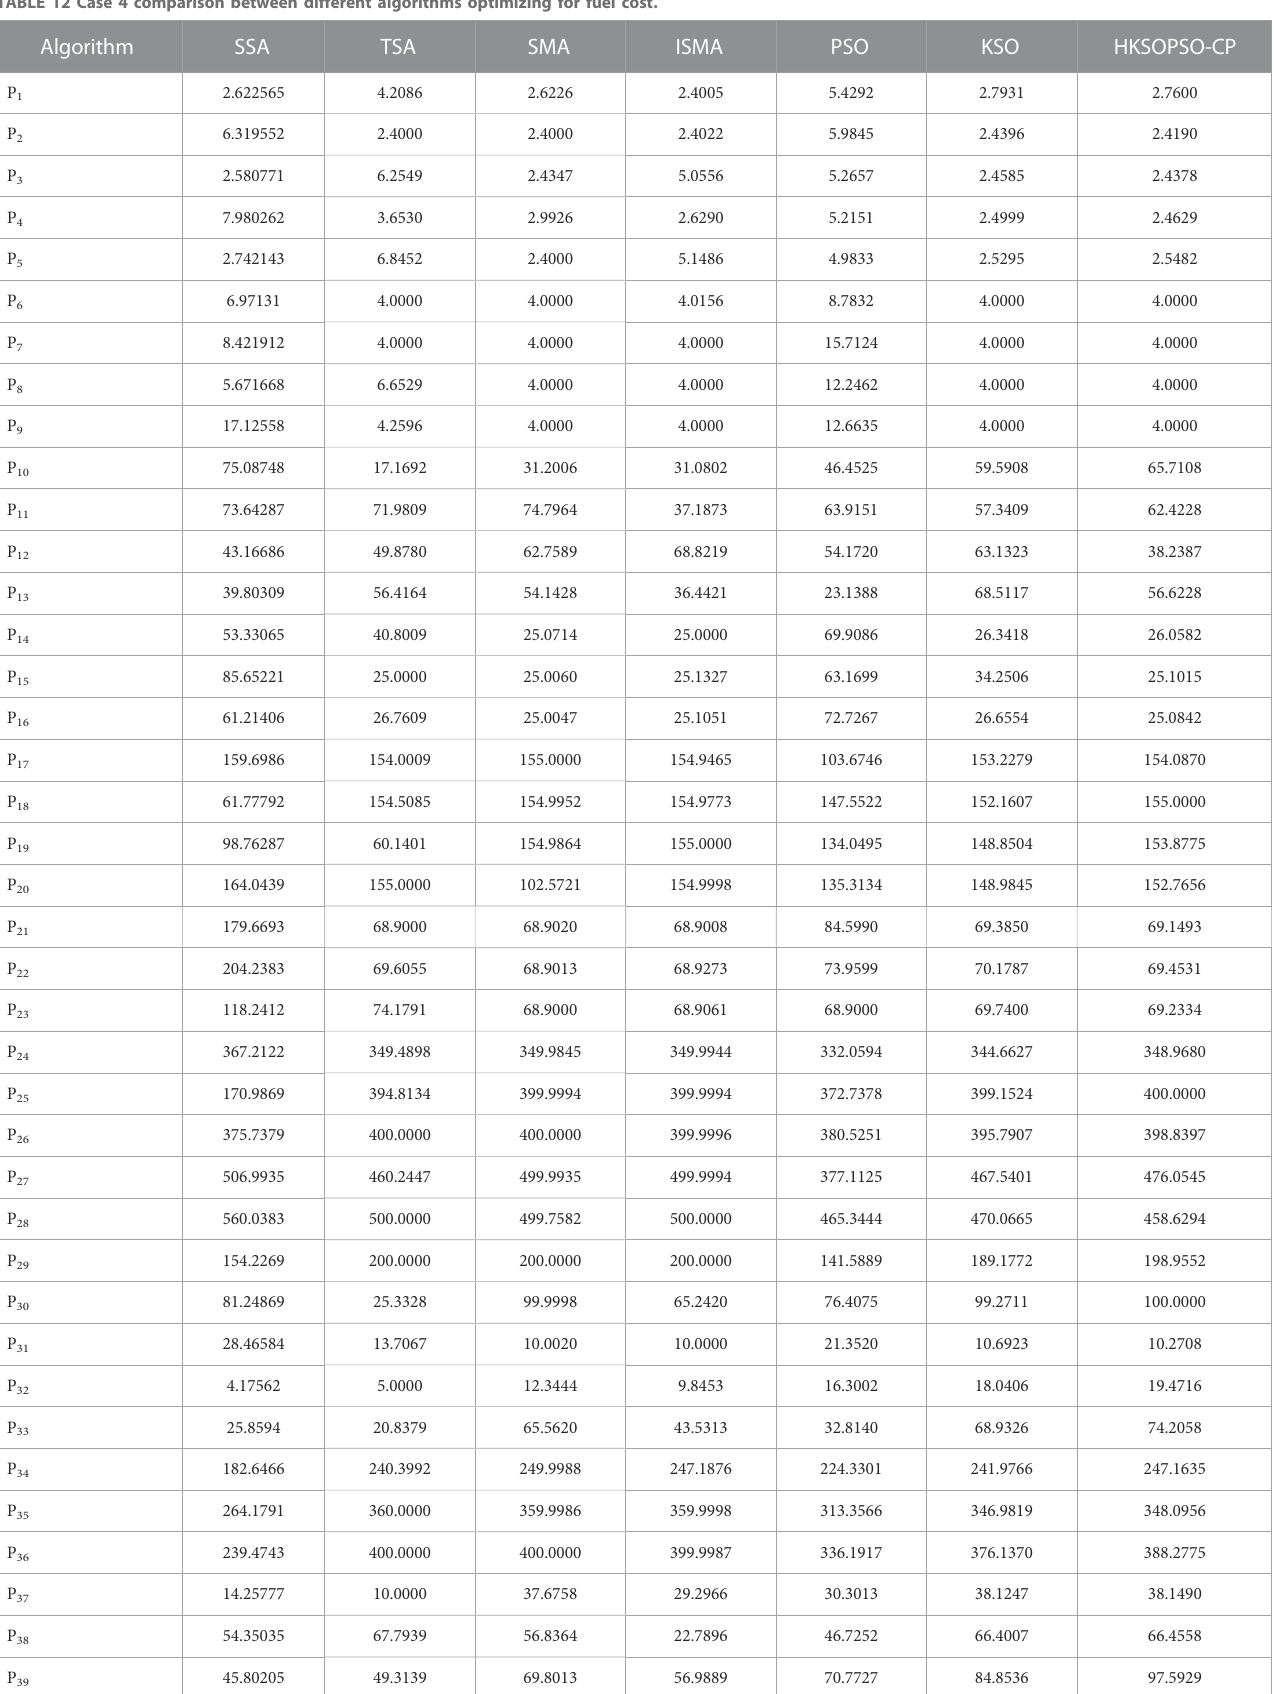
TABLE 12 Case 4 comparison between different algorithms optimizing for fuel cost.